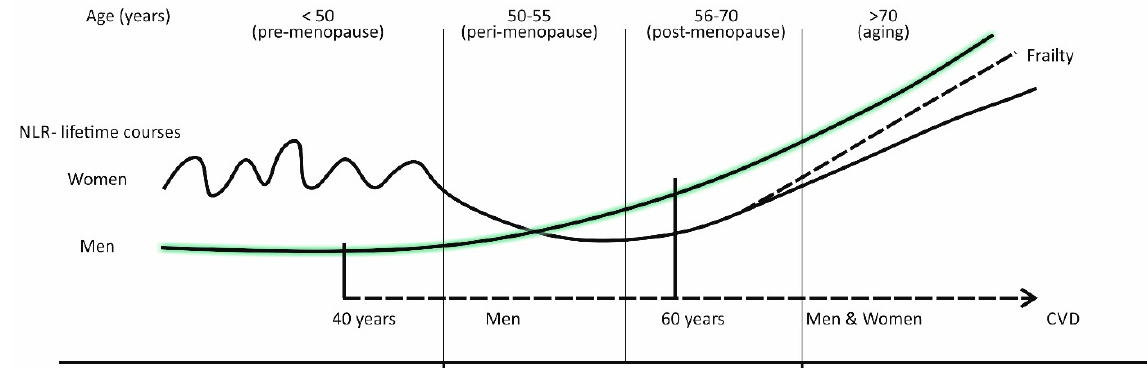
Figure 2. The sex specific lifetime courses of the inflammatory marker “neutrophil-to-lymphocyte ratio” (NLR).